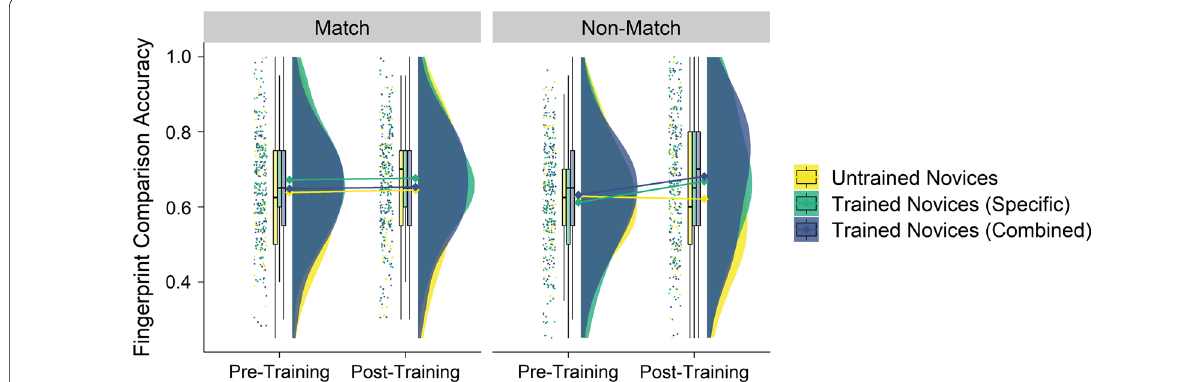
Fig. 11 Fingerprint match and non-match accuracy pre-to-post-training between untrained novices, domain-specific trained novices, and domain-combined trained novices in Experiment 2